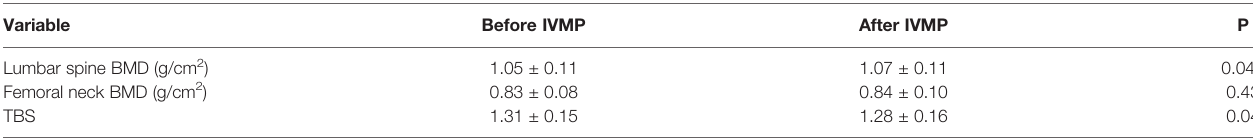
Continuous variables are presented as means ± SD. BMD, bone mineral density; IVMP, intravenous methylprednisolone; SD, standard deviation; TBS, trabecular bone score.